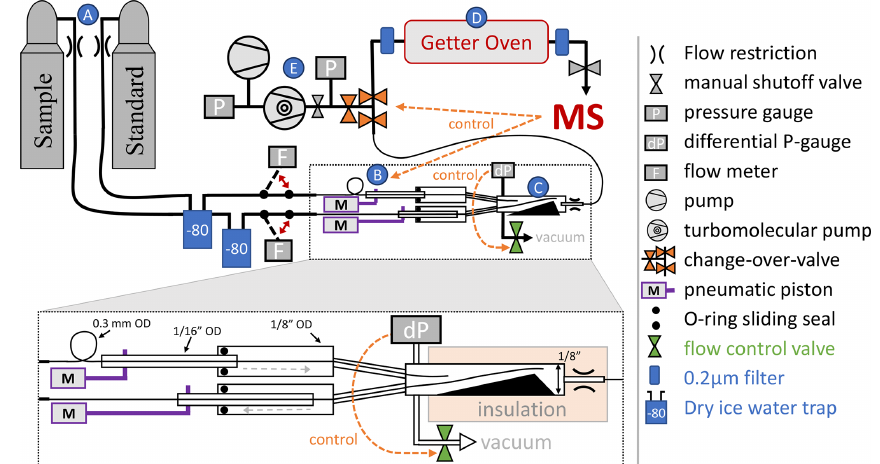
Figure 2. Schematic depiction of the flow-stabilizing MS inlet system. Dashed orange arrows highlight important control pathways, and letters A–E in blue circles label the main sections of the inlet system. Red double arrows indicate the manual switching option in the inlet system. Sample or standard gas is delivered from high-pressure cylinders (A). The flow can be measured by two Omron flow meters before entry into the pressure stabilization chamber (C). Pistons (B) alternately move fine metal tubing in the pressure stabilization chamber, pushing either the sample or standard gas stream deeper into the stabilization chamber where the gas will be picked up by a single capillary leading to the MS. A sliding seal is made using lubricated O-rings between 1 / 8 (0.3175cm) and 1 / 16in. (0.15875cm) o.d. tubing at the entry to the pressure-stabilized chamber. This ensures sufficient rigidity and protects the fine metal tubing inside. The chamber is exhausted to a vacuum system and the pressure is monitored and controlled by a differential pressure gauge combined with an automatic MKS flow control valve. The stainless-steel getter oven (D) has an inner diameter of 1 / 2in. (1.27cm) and is filled with 10–12g of titanium sponge. 2µm filters prevent particles from contaminating the MS and gas delivery system. In case of an anomalous pressure change in the MS or when venting the getter oven, the getter oven can be isolated from the pressure-stabilization chamber with a changeover valve controlled directly by the MS software. The entire inlet vacuum system is backed by a diaphragm vacuum pump and a turbomolecular pump (E). A manual shutoff valve can isolate the getter oven from the